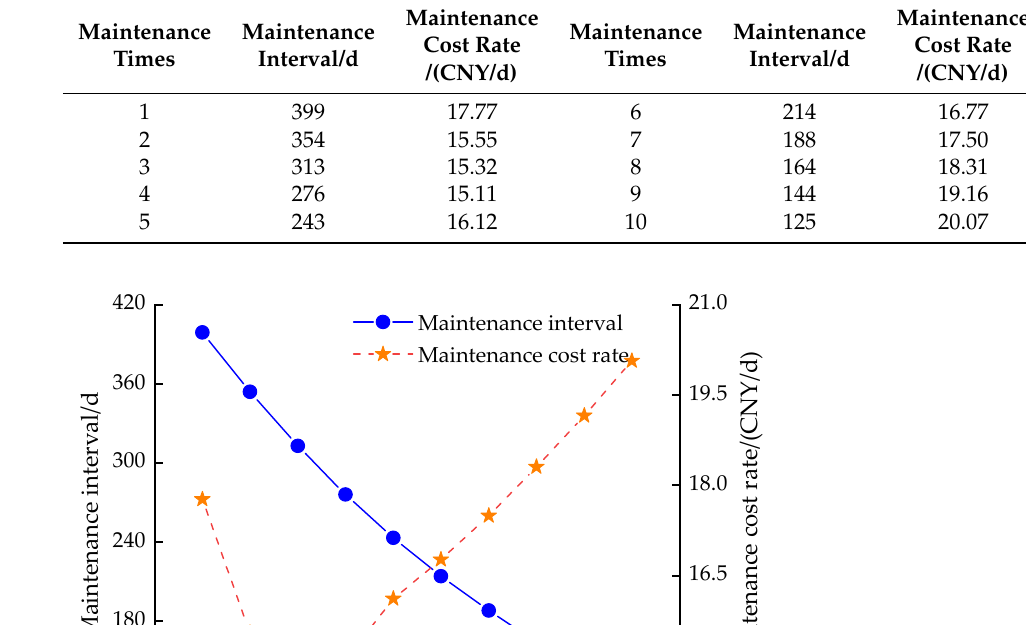
Table 2. Solution result of maintenance model for the power supply module.